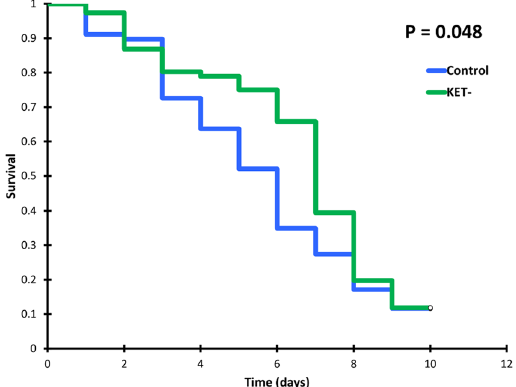
Figure 3. Survival curves of mosquitoes feeding on blood from one fully untreated pig (control) vs mosquitoes feeding on a ketoconazole-only treated pig (Ket-). Triplicate experiments, n = 222.